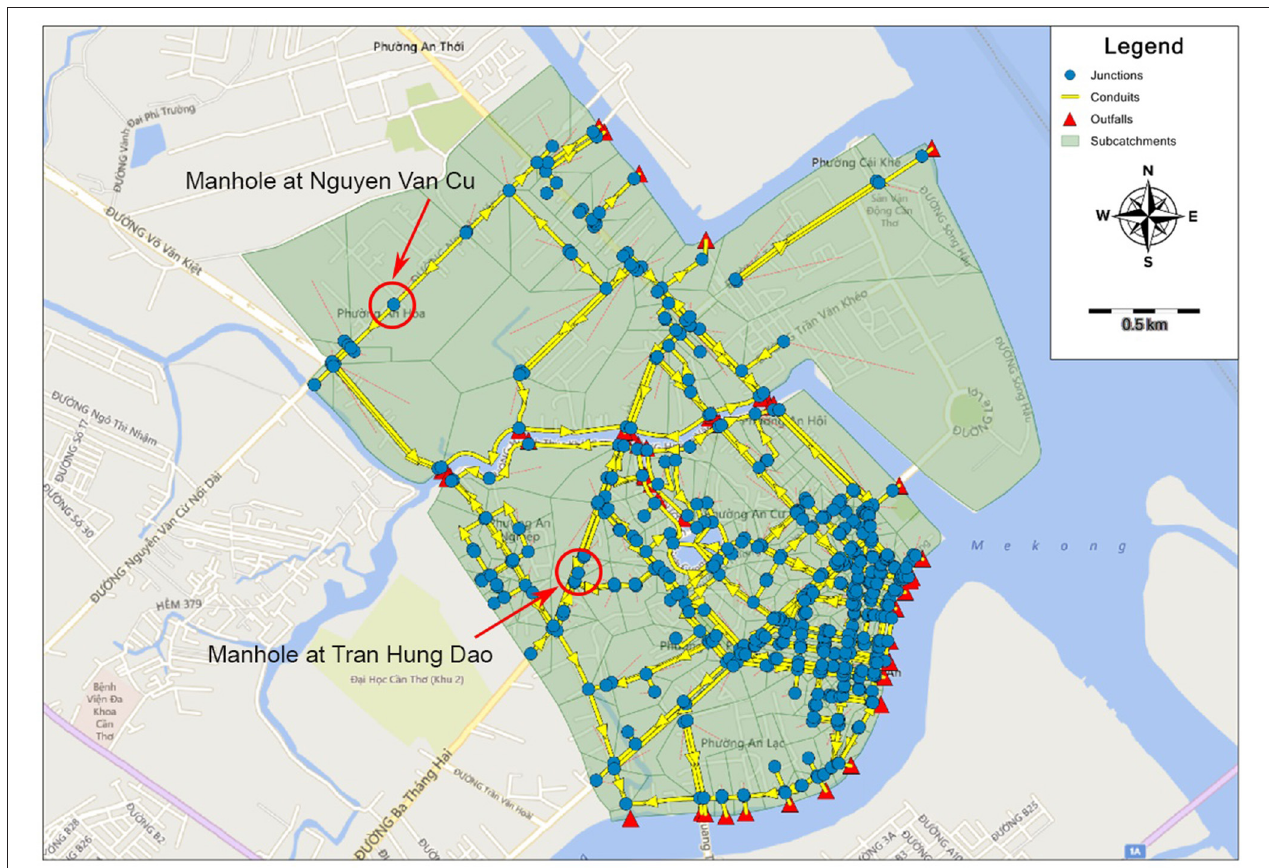
FIGURE 5 | The detailed 1D urban flood drainage model for the study area developed by Huong and Pathirana (2013) (Base map is from Bing Maps Road ©